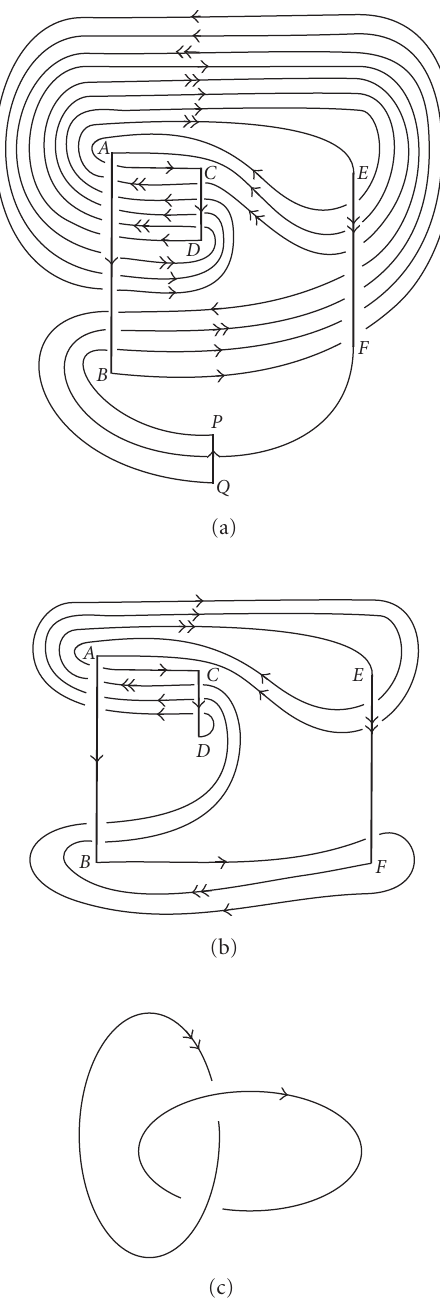
Figure 3.3. A sequence of Reidemeister moves yielding the Hopf